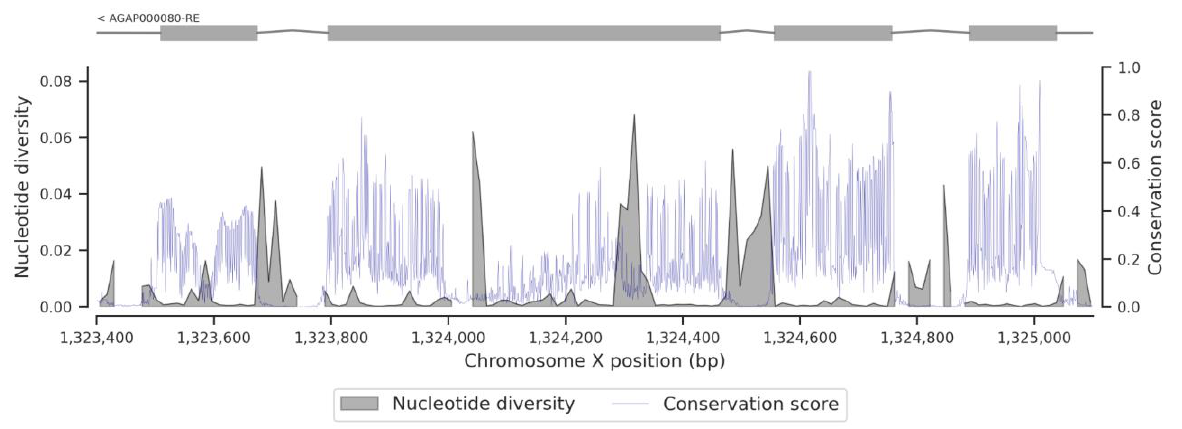
Figure A6. Conservation score and nucleotide diversity in a window of 12 bp within the BTB and connector region of the Fruitless gene; upper figure shows the BTB and connector region (rectangles correspond to the exonic regions, and the simple lines are the intronic regions); lower figure shows the conservation score (blue line) and the nucleotide diversity (dark fill) plot.